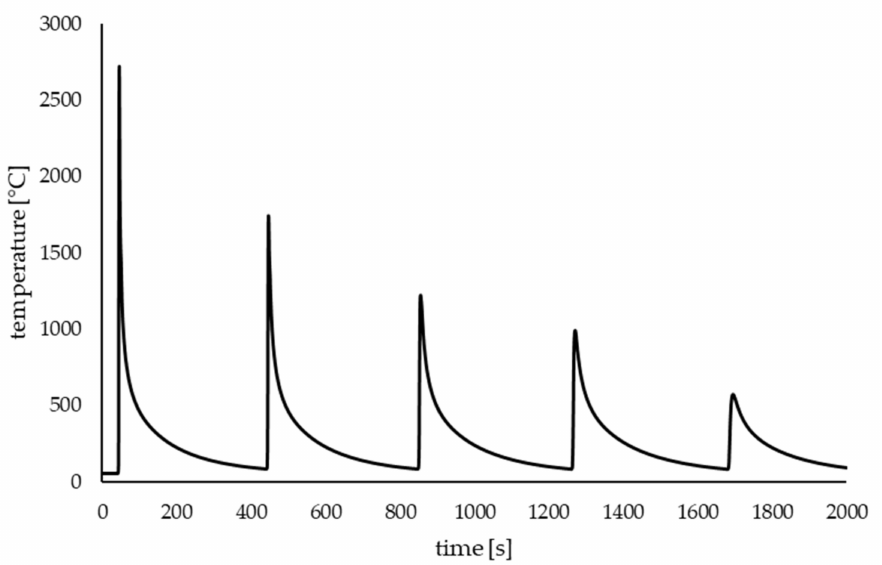
Figure 15. Time-temperature cycle in the welding simulation for wall structure (length 300 mm) and energy input per unit length 8 kJ/cm with layer 25.